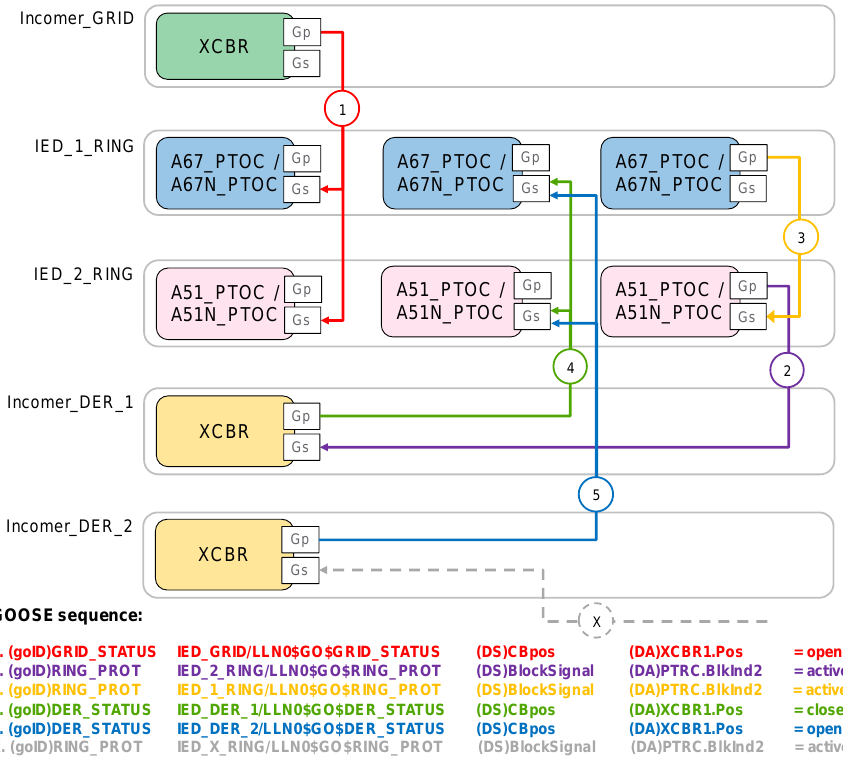
Figure 13. GOOSE publication and subscription between several IEDs.